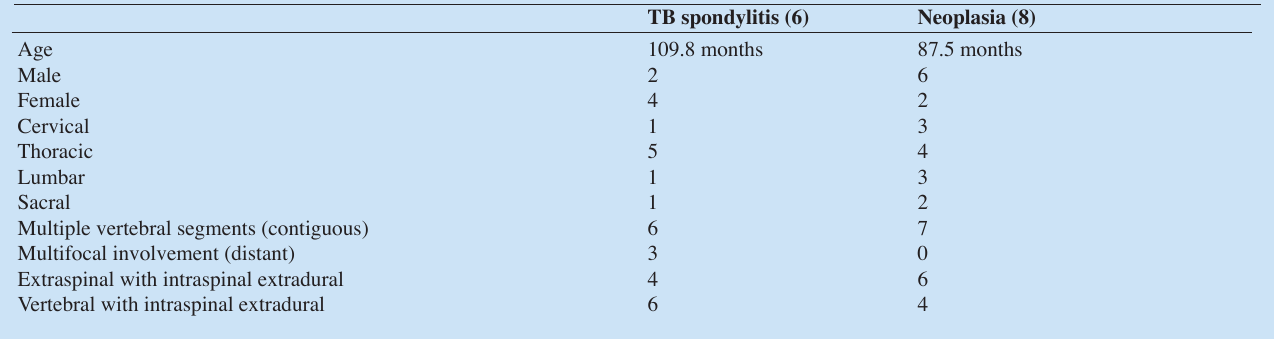
Table I. Comparison of TB spondylitis with neoplasia for anatomical